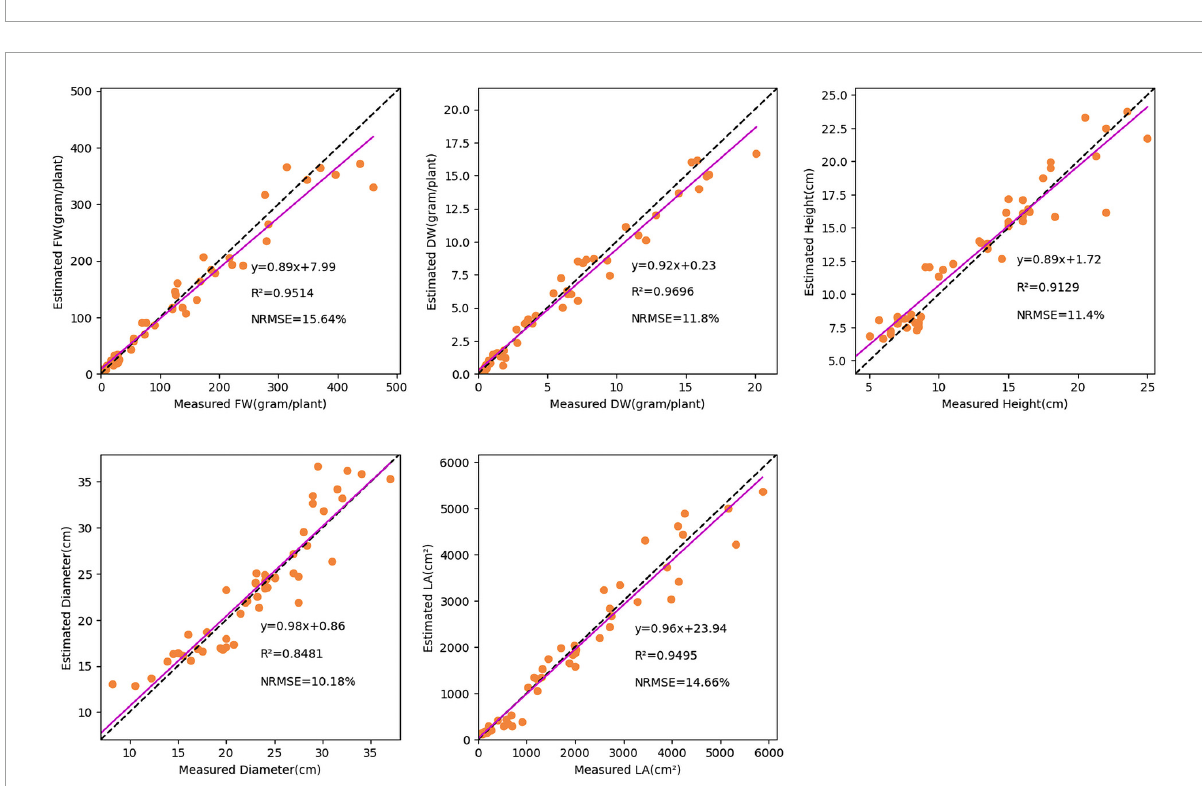
FIGURE7 Estimation result of lettuce traits based on the TMSCNet. Five subgraphs show the estimated results of FW, DW, H, D, and LA,